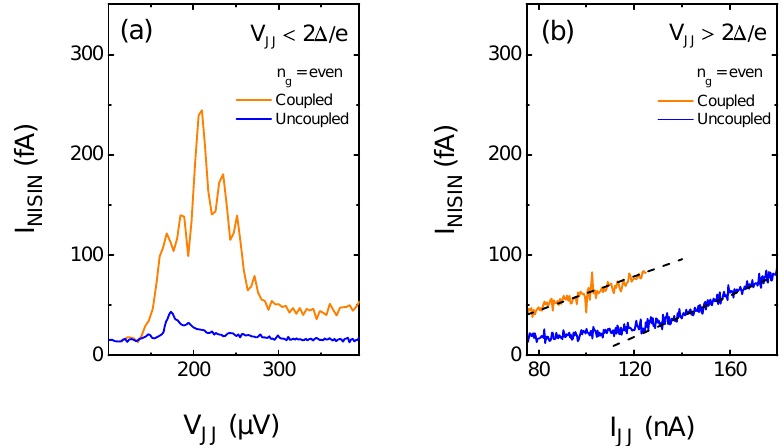
Figure 9. ( a ) The detector signal for the coupled (orange curve) and the uncoupled source (blue curve) operating in the subgap voltage region. The signal of the uncoupled source was scaled down by a factor ( I C,Coupled / I C,Uncoupled ) 2 = 0.28 for the sake of adequate comparison to account for the difference in the radiated microwave power. The coupled and uncoupled source critical currents are different due to technological reasons; ( b ) The detector signals for the same two sources biased in the quasiparticle branch V JJ > 2 ∆ / e . The signal increases with the same slope for both sources (black dashed